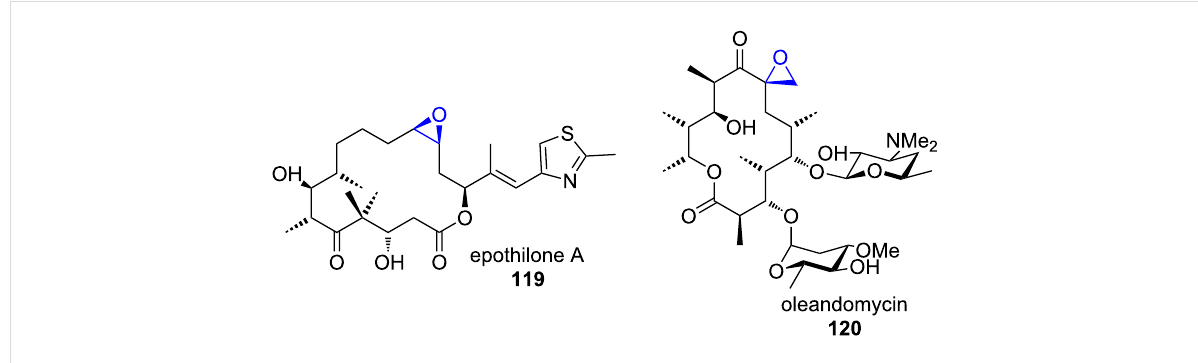
Figure 4: Structures of the epoxide-containing polyketides epothilone A (119) and oleandomycin ( 120 ) [123-125].